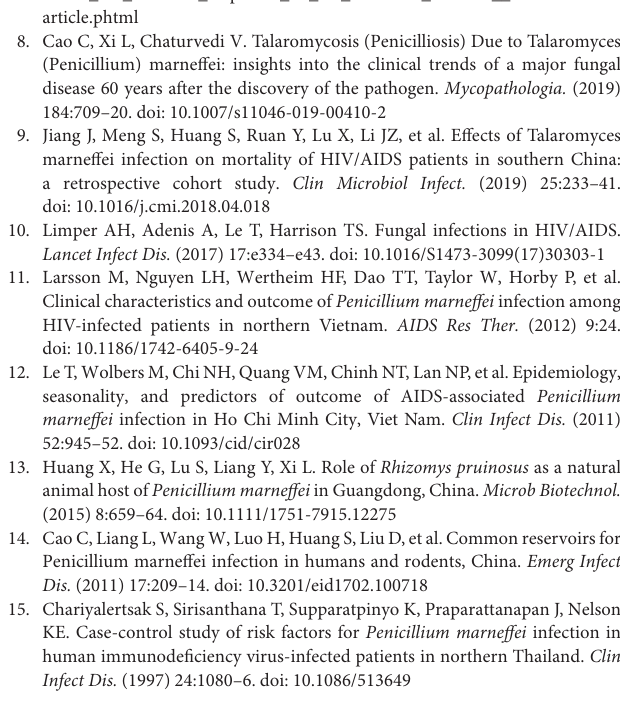
environmental variables. Supplementary Table S7 | Demographic and clinical features of patients stratified by